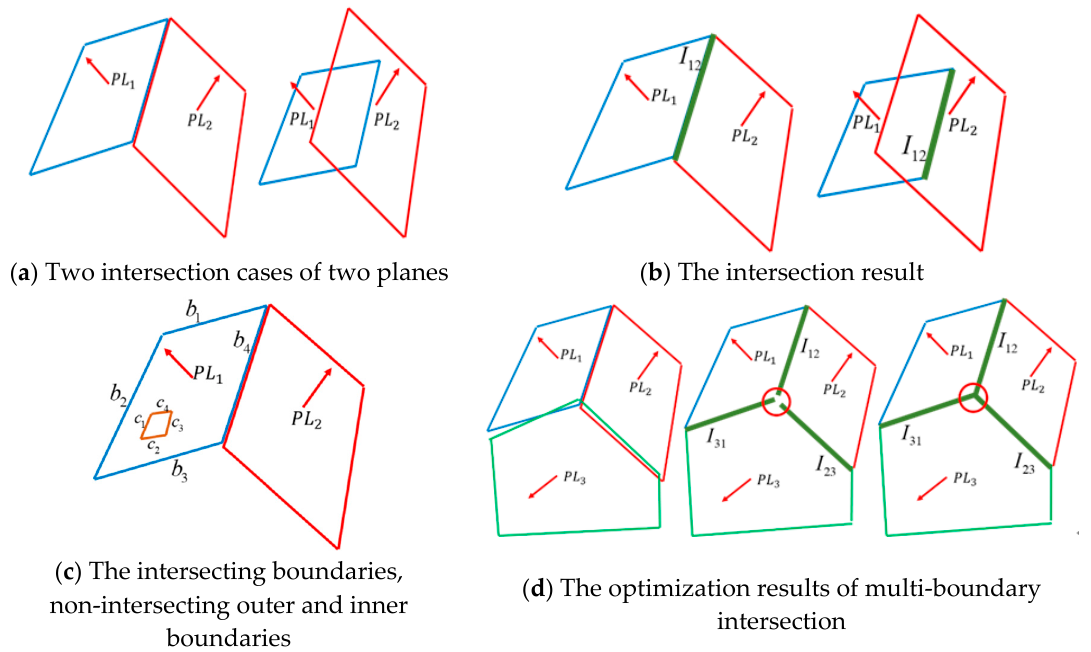
Figure 8. Illustration of boundaries intersection and optimization.